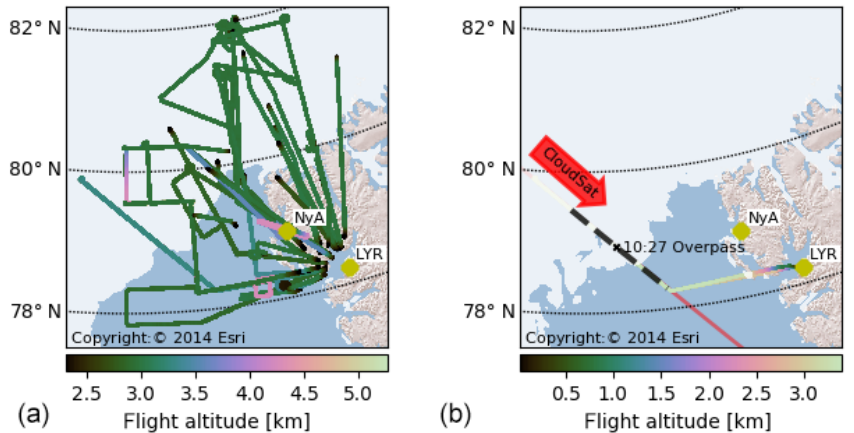
Figure 4. (a) Tracks of all research flights of Polar 5 during ACLOUD around Svalbard with an altitude h (above sea level) larger than 2.3km, (cid:15) < 10 ◦ , and | ρ | < 3 ◦ . (b) Polar 5 CloudSat underflight on 27 May between 10:06 and 10:44UTC west of Svalbard. In red the CloudSat track is shown. The white colored area shows the 15% sea ice coverage derived from AMSR2